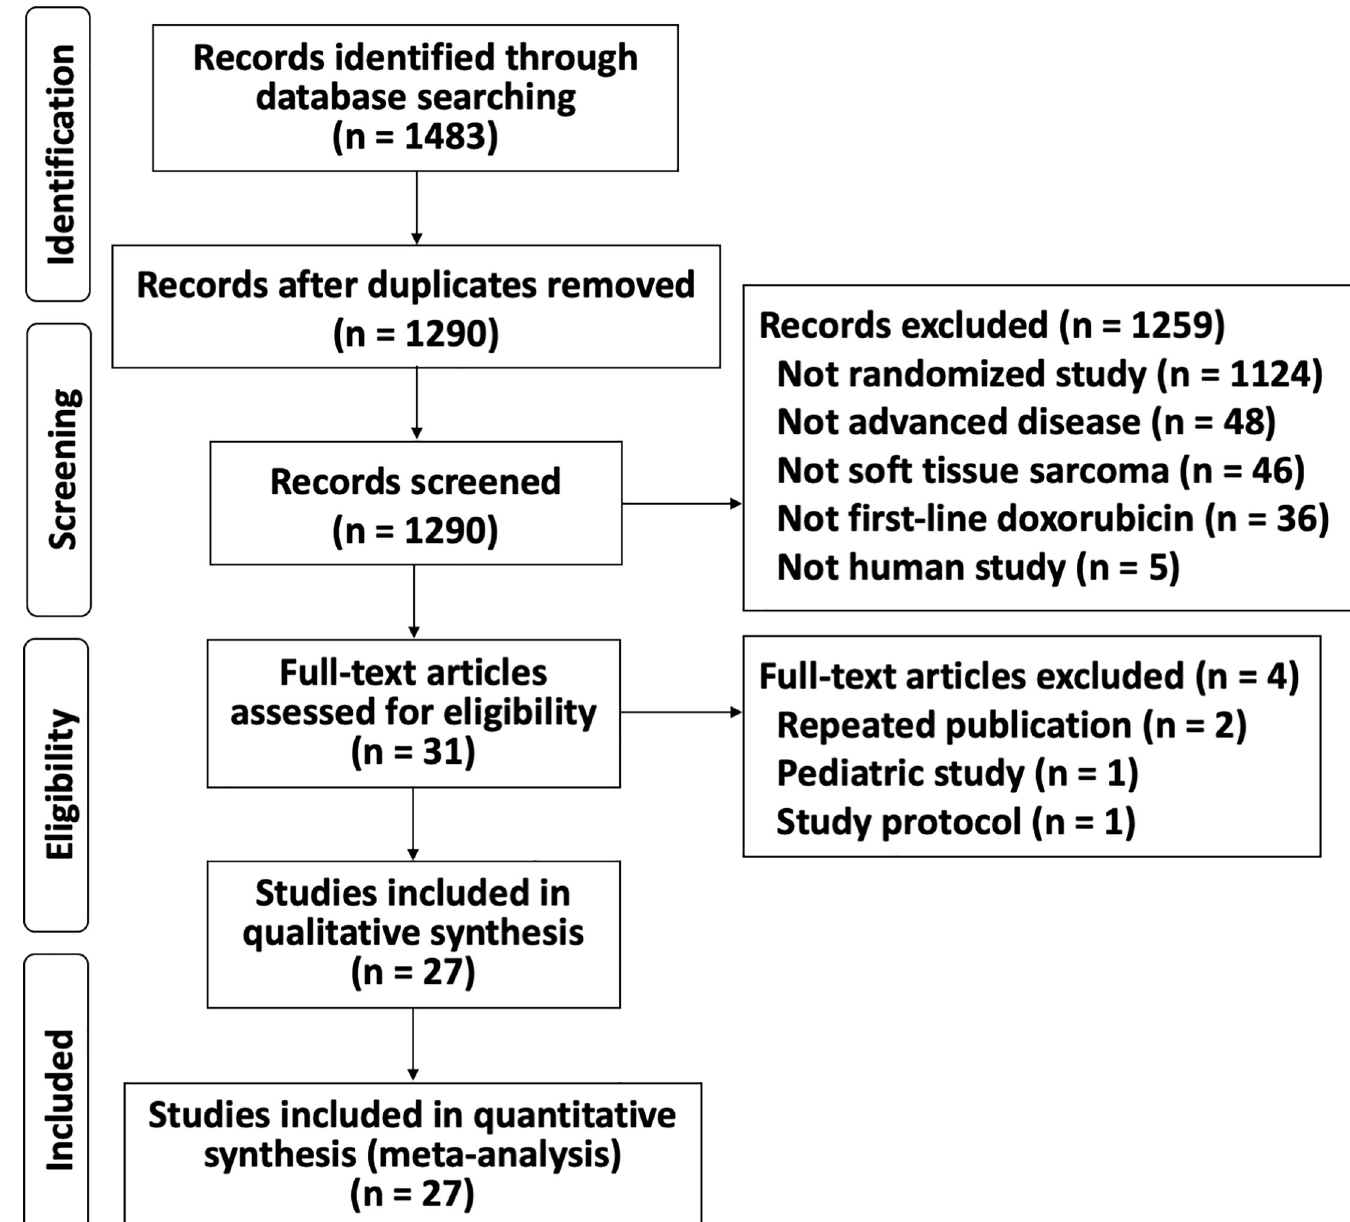
Fig 1. PRISMA flow diagram. PRISMA, Preferred Reporting Items for Systematic Reviews and Meta-Analyses.